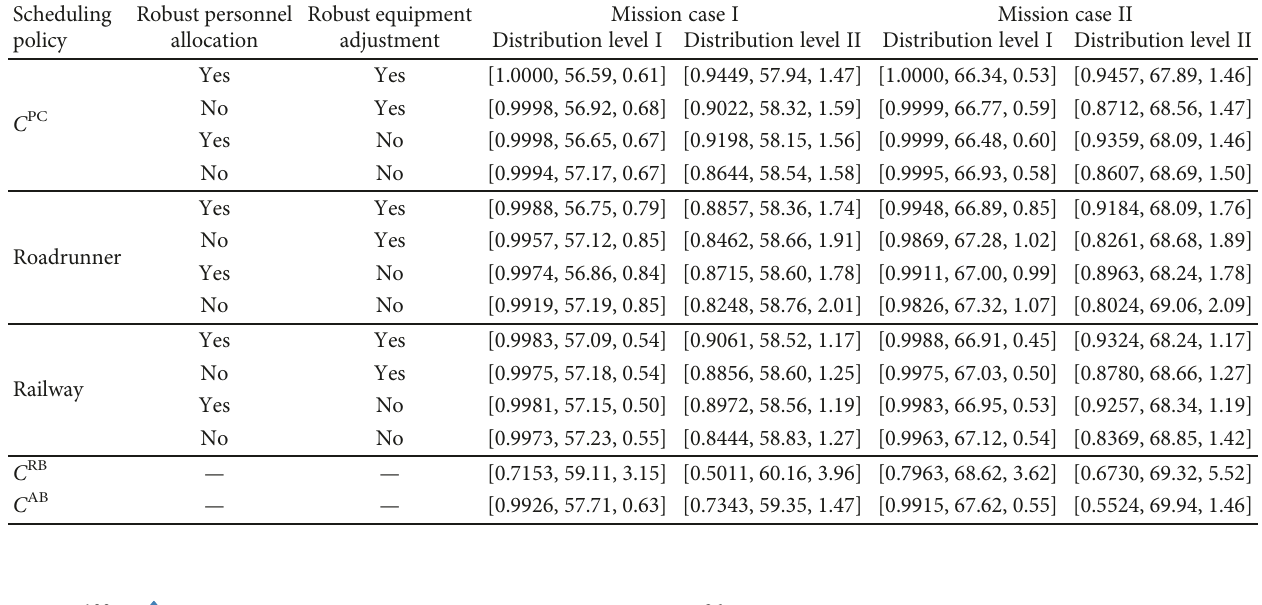
Table 16: Results of resource allocation scheme combinations and scheduling policies (25,000 schedule).